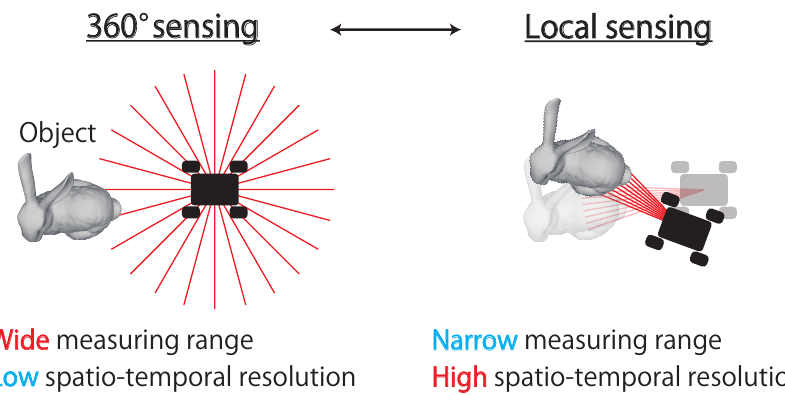
Figure 1. Mission scenario with adaptive 3D sensing system, which is referred to as